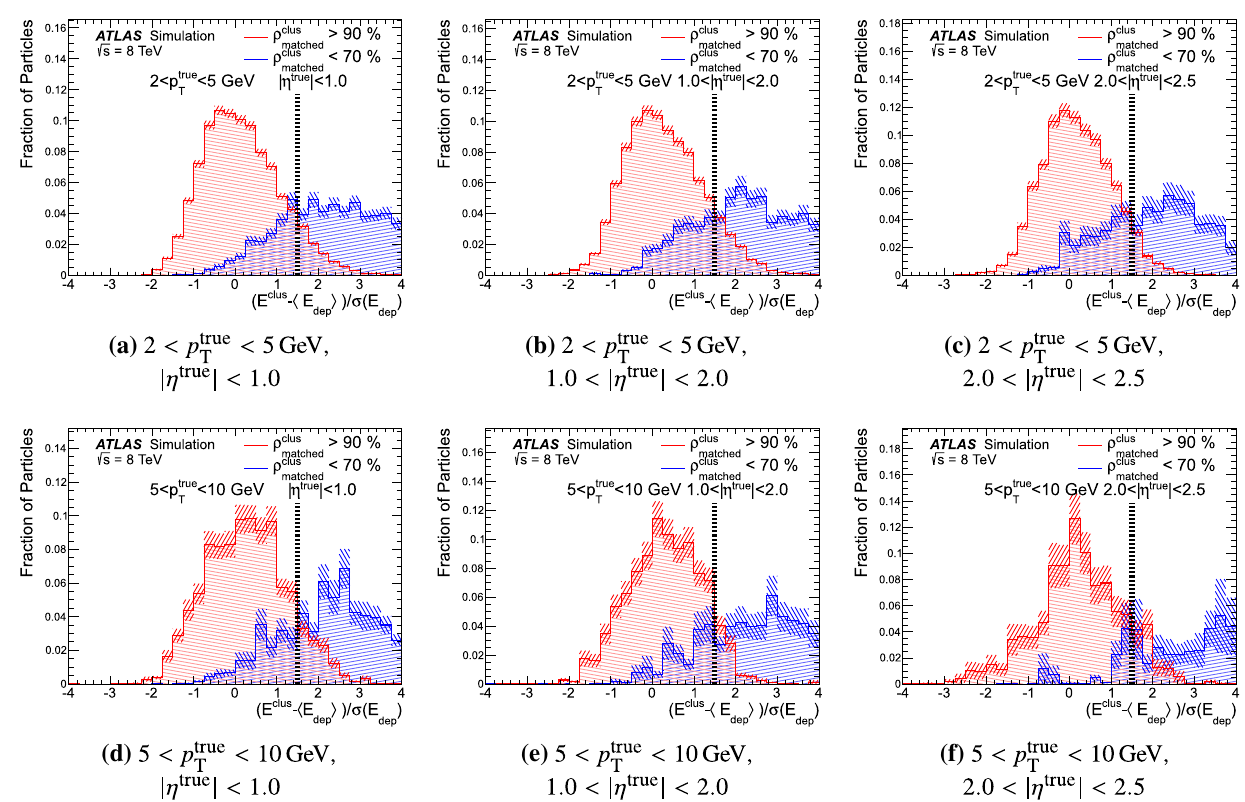
> 90% the remnant is successfully removed cate that when ρ clus matched ( 91 , 89 , 94 , 89 , 91 , 88 ) % of the time; while when ρ clus < 70% the matched remnant is retained ( 81 , 80 , 76 , 84 , 83 , 91 ) % of the time. The data are < 500GeV and taken from a dijet sample without pile-up with 20 < p lead T T and the statistical uncertainties on the number of MC simulated events are shown as a hatched